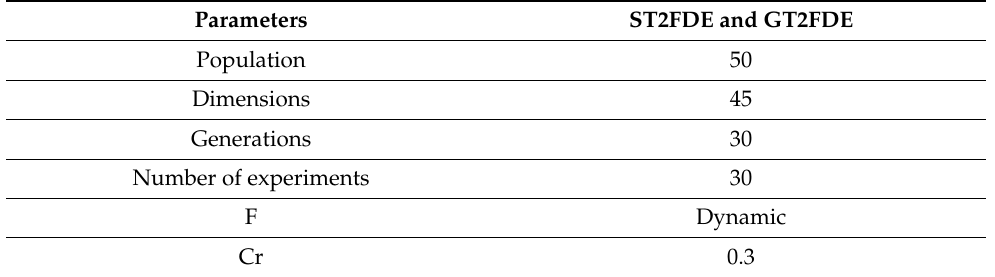
Table 4. Parameters of the algorithm.